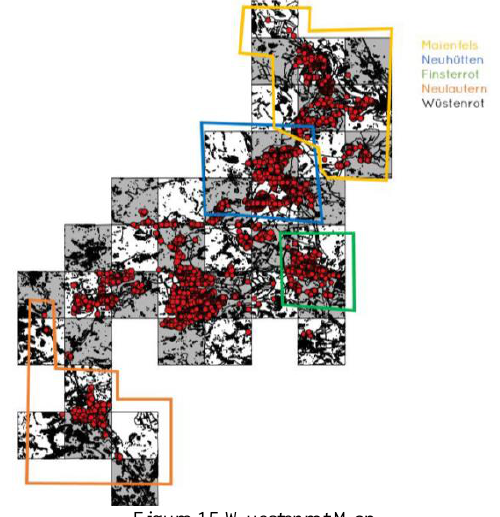
Figure 15 Wuestenrot